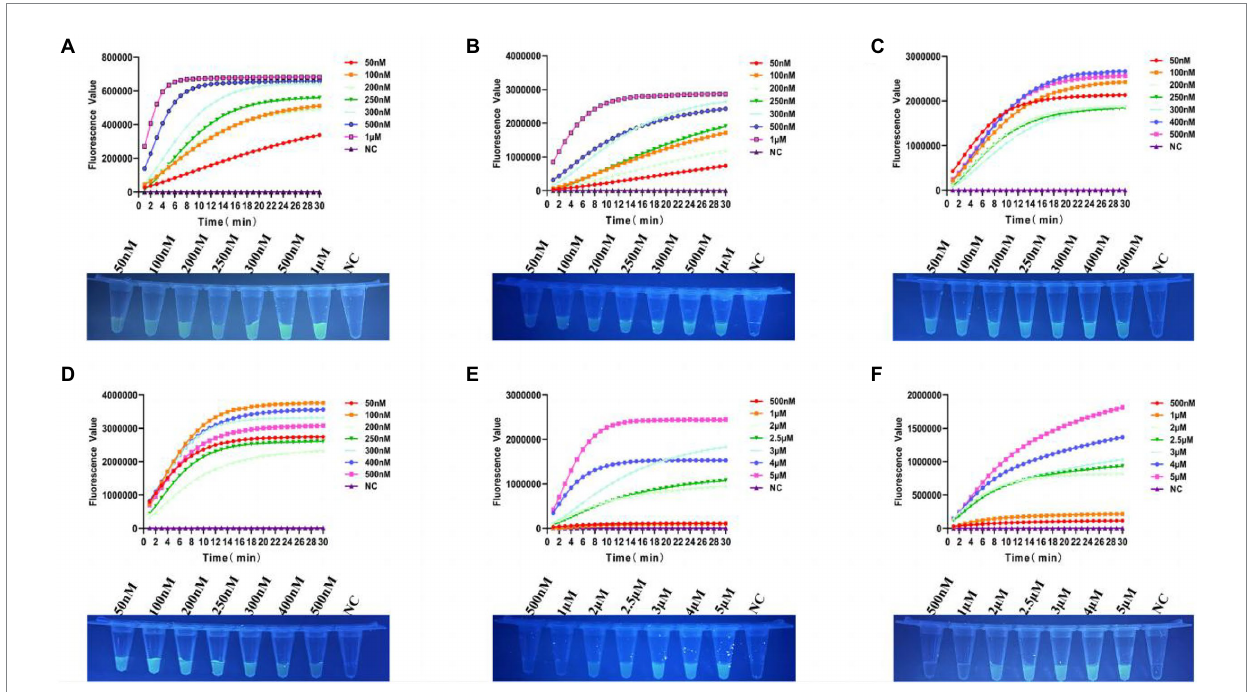
FIGURE 3 Optimization of the Cas12a reaction system. (A) Optimization of Cas12a concentration for tcdA gene. (B) Optimization of Cas12a concentration for tcdB gene. (C) Optimization of crRNA concentration for tcdA gene. (D) Optimization of crRNA concentration for tcdB gene. (E) Optimization of ssDNA-FQ concentration for tcdA gene. (F) Optimization of ssDNA-FQ concentration for tcdB gene. NC, negative control. All experiments were repeated at least 3